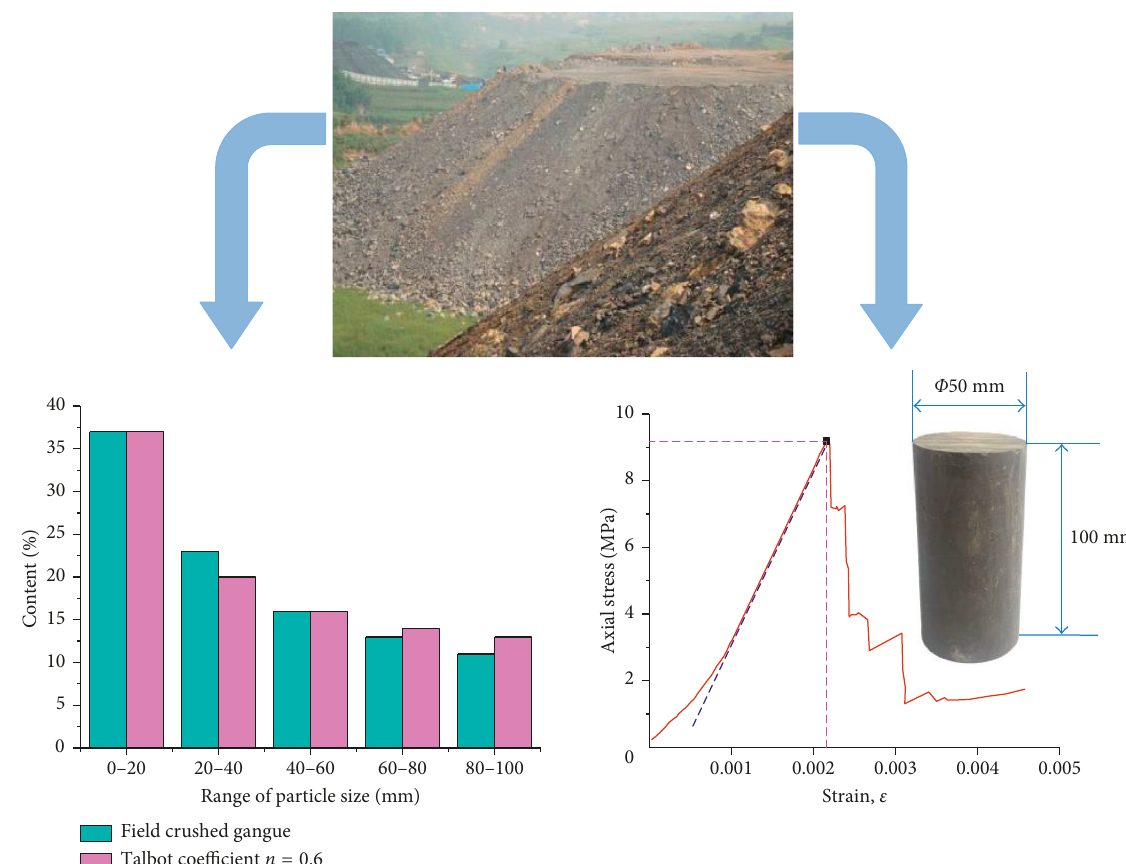
Figure 2: Gangue strength and particle size